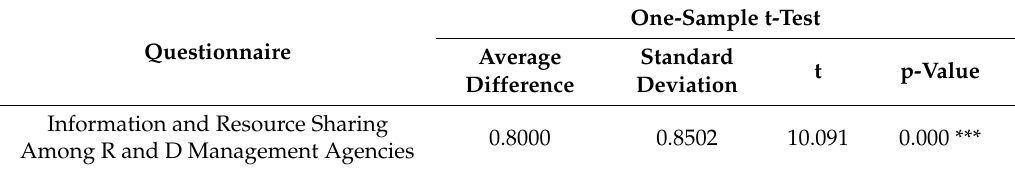
Table 9. Information- and resource-sharing between R and D management agencies.